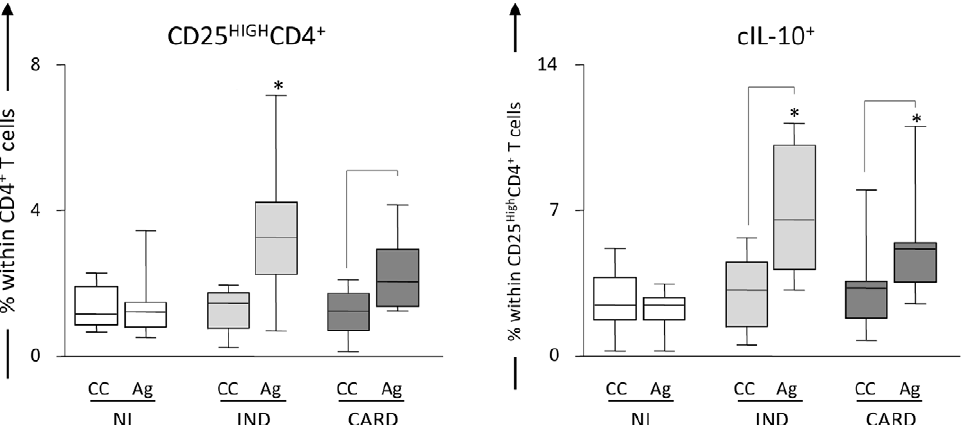
Figure 1. Analysis of IL-10 + CD25 High CD4 + regulatory T cells in the peripheral blood from chagasic patients. Frequency of regulatory T cells and intracytoplasmic IL-10 (cIL-10) levels in CD25 High CD4 + cells from patients with distinct clinical forms of Chagas’ disease (IND, light gray box; CARD, dark gray box) and non-infected individuals (NI, white box) following short-term in vitro stimulation of whole blood samples with T. cr u zi antigens. Baseline levels of CD25 High CD4 + and cIL-10 + T cells were obtained from control cultures (CC) maintained under the same conditions (22